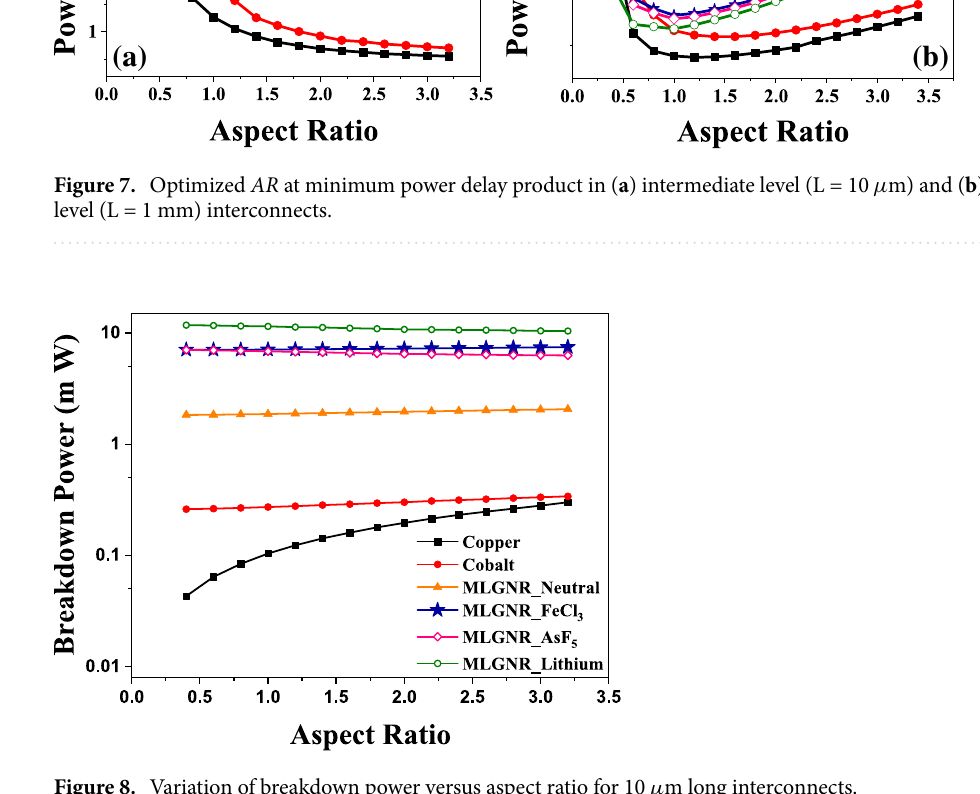
Figure 8. Variation of breakdown power versus aspect ratio for 10 µ m long interconnects.